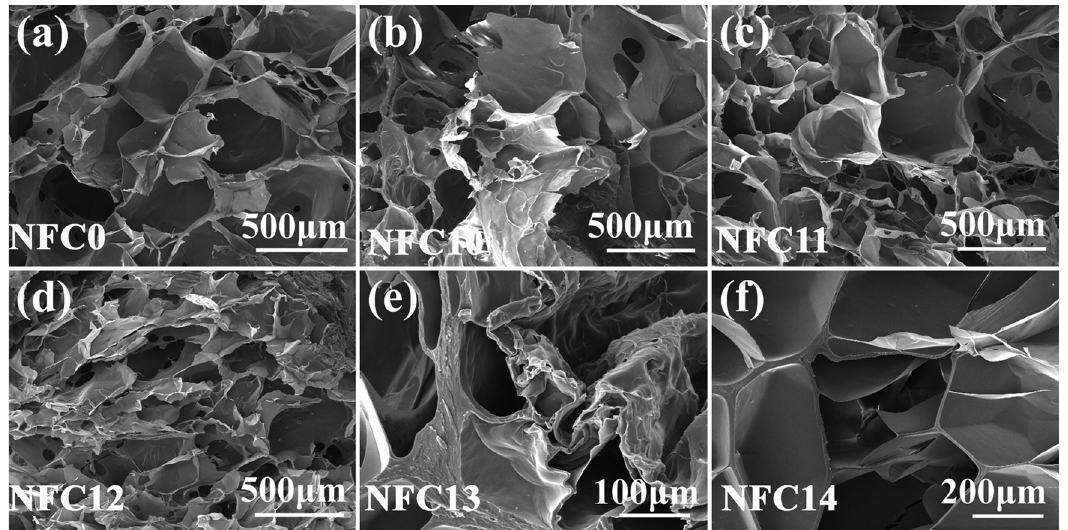
Figure 1: Microstructure characteristics of intelligent hydrogels with NFC contents of ( a ) 0 mg/mL, ( b ) 10 mg/mL, ( c ) 11 mg/mL, (